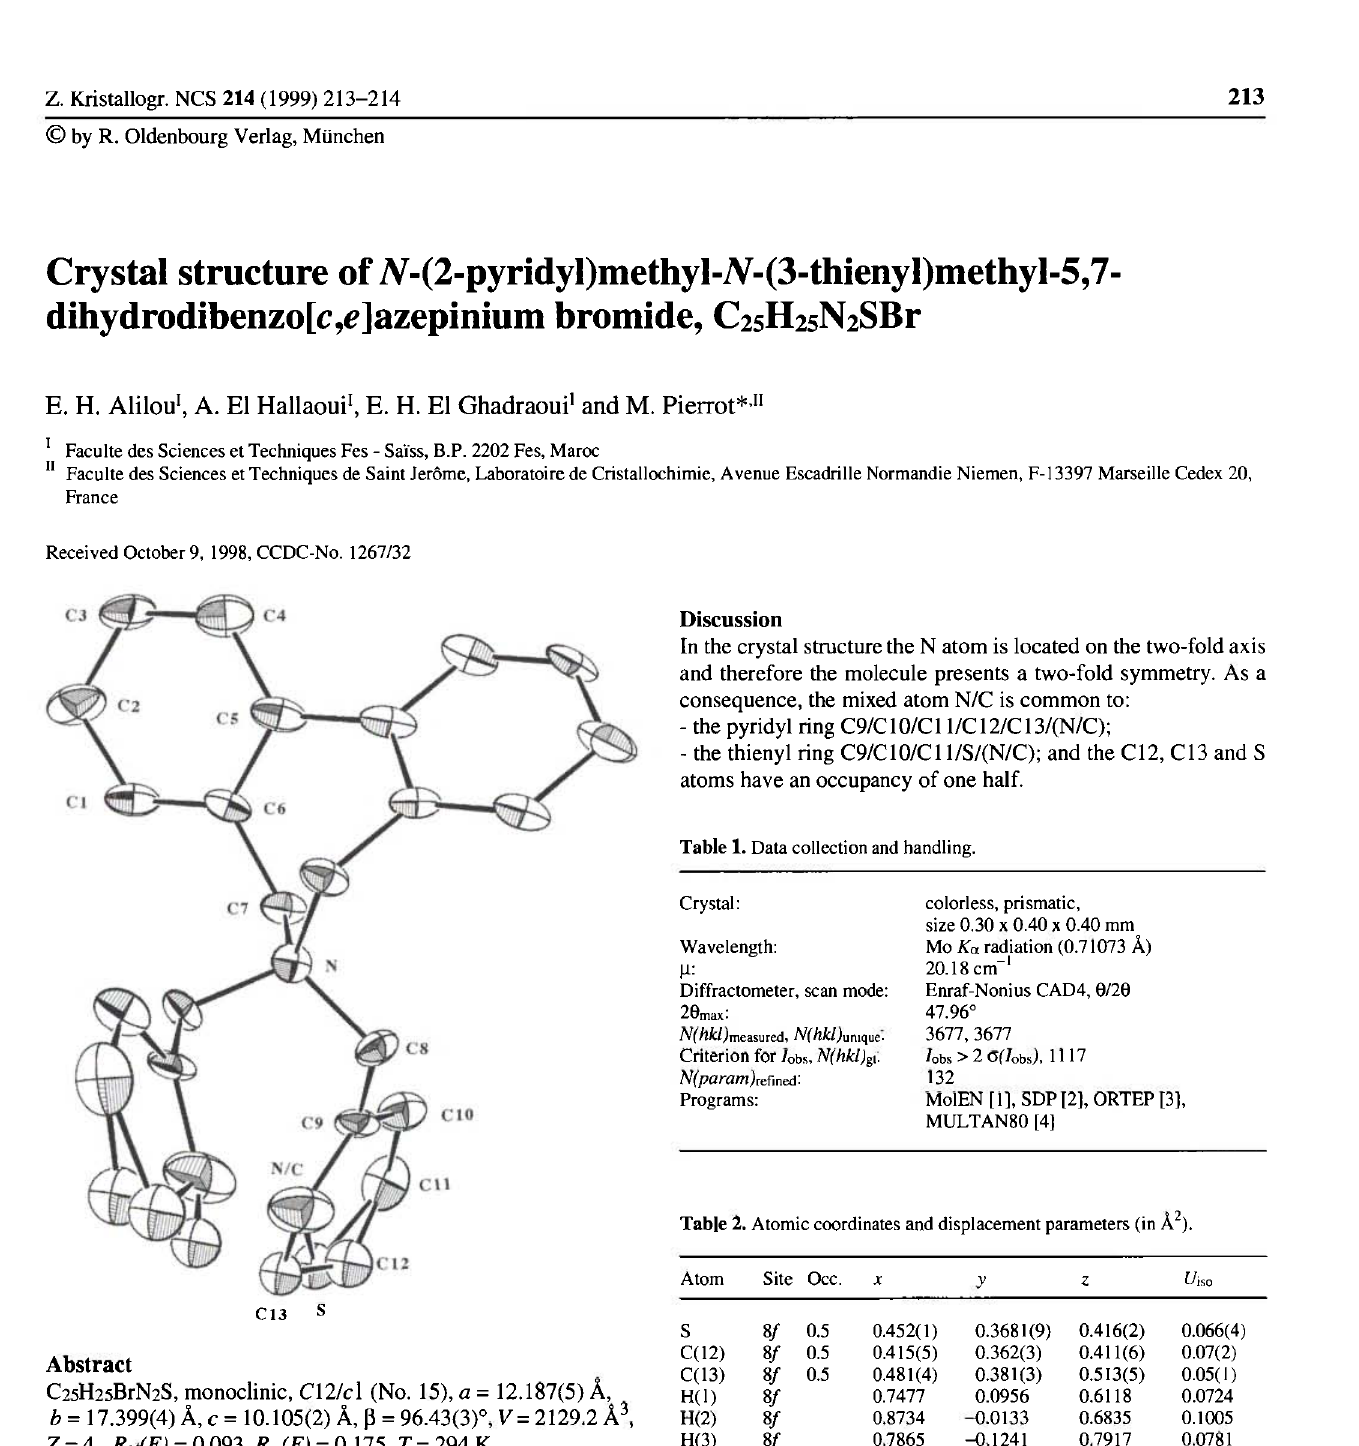
Table 2. Atomic coordinates and displacement parameters (in Ä 2